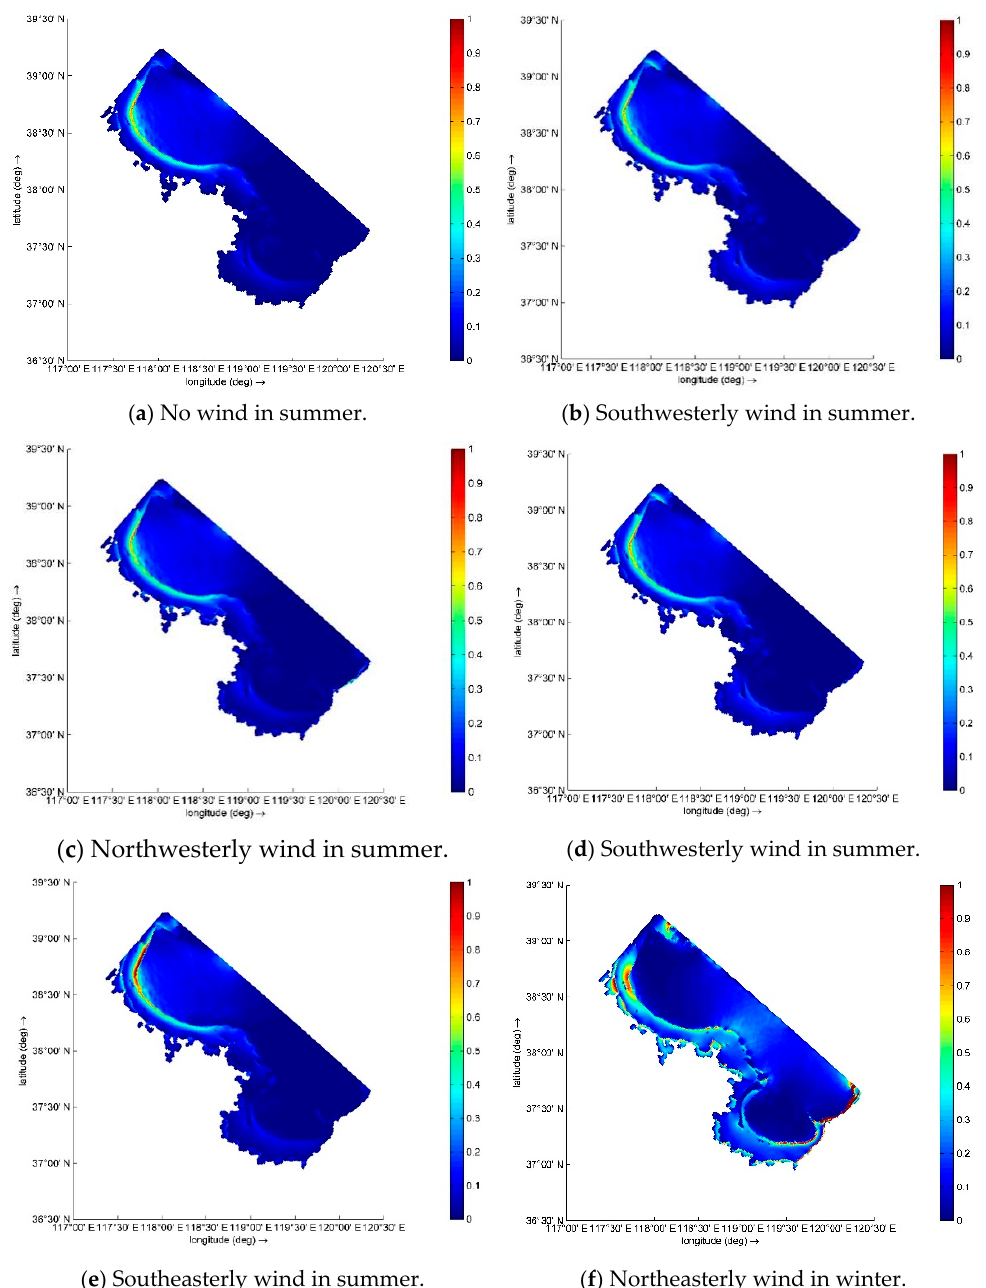
Figure 5. The shear stress on the bottom bed at the Yellow River Delta under no wind ( a ), northeast wind ( b ), northwest wind ( c ), southwest wind ( d ), southeast wind ( e ) in summer and northwest wind ( f ) in winter (Unit: Pa) [33].